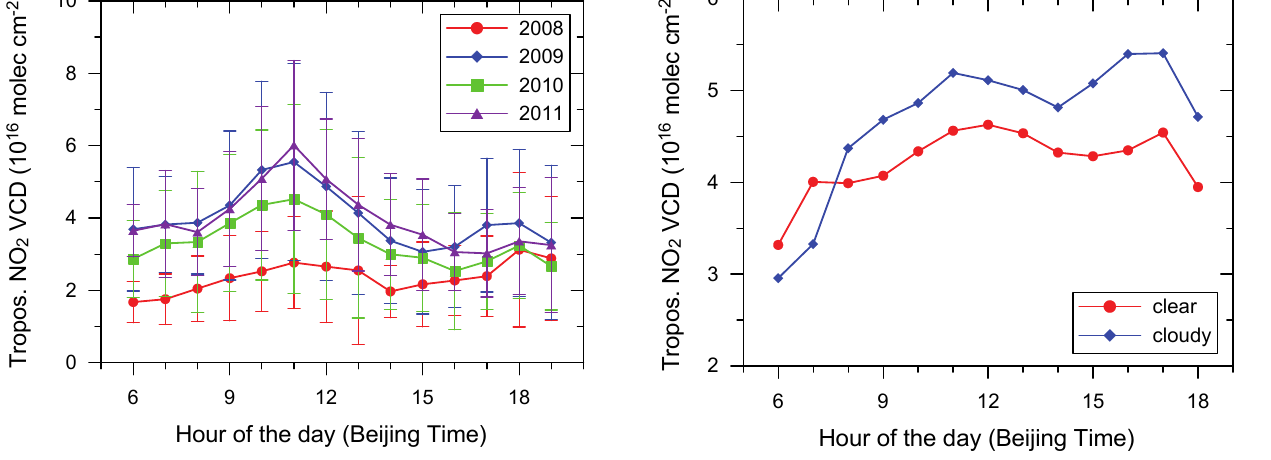
Fig. 11. Diurnal variations of the tropospheric NO 2 VCD under clear and cloudy conditions, averaged over the period of August 2008 to September 2011.